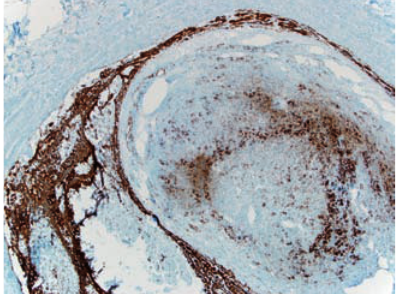
Figure 11. CD61stain shows platelet thrombus (IHC stain for CD6, 100 ¥ mag- nification).